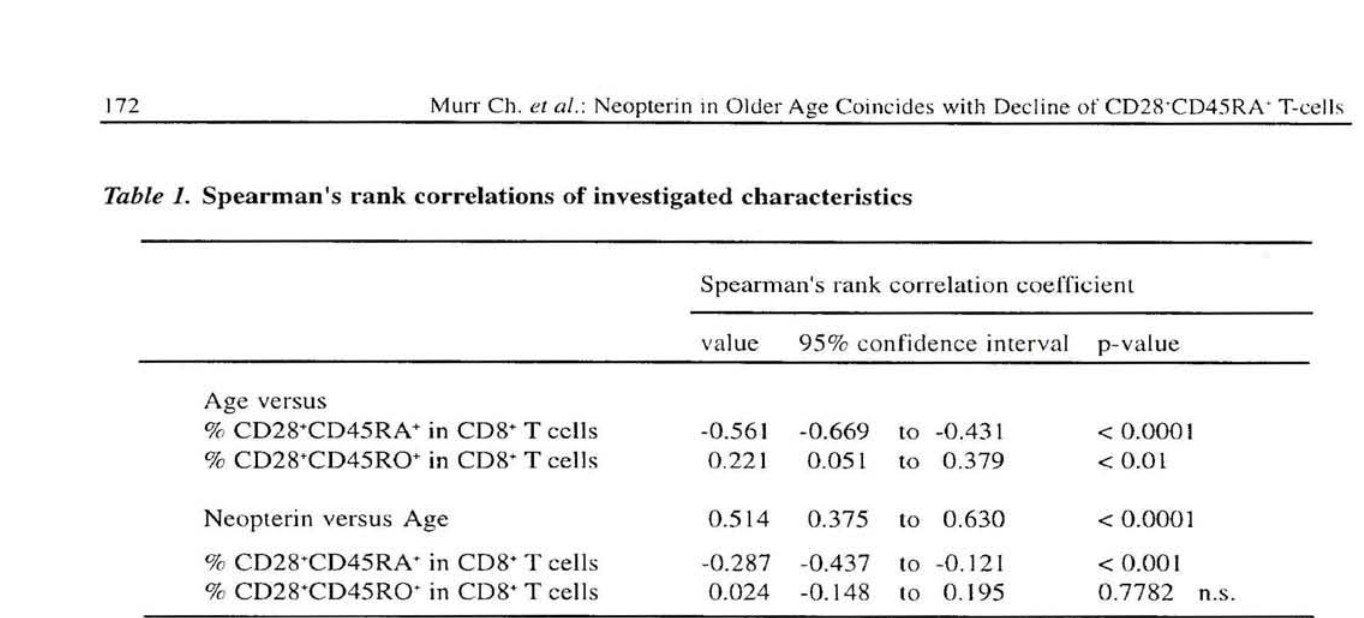
Spearman's rank correlation coelTicient value 95% confidence interval